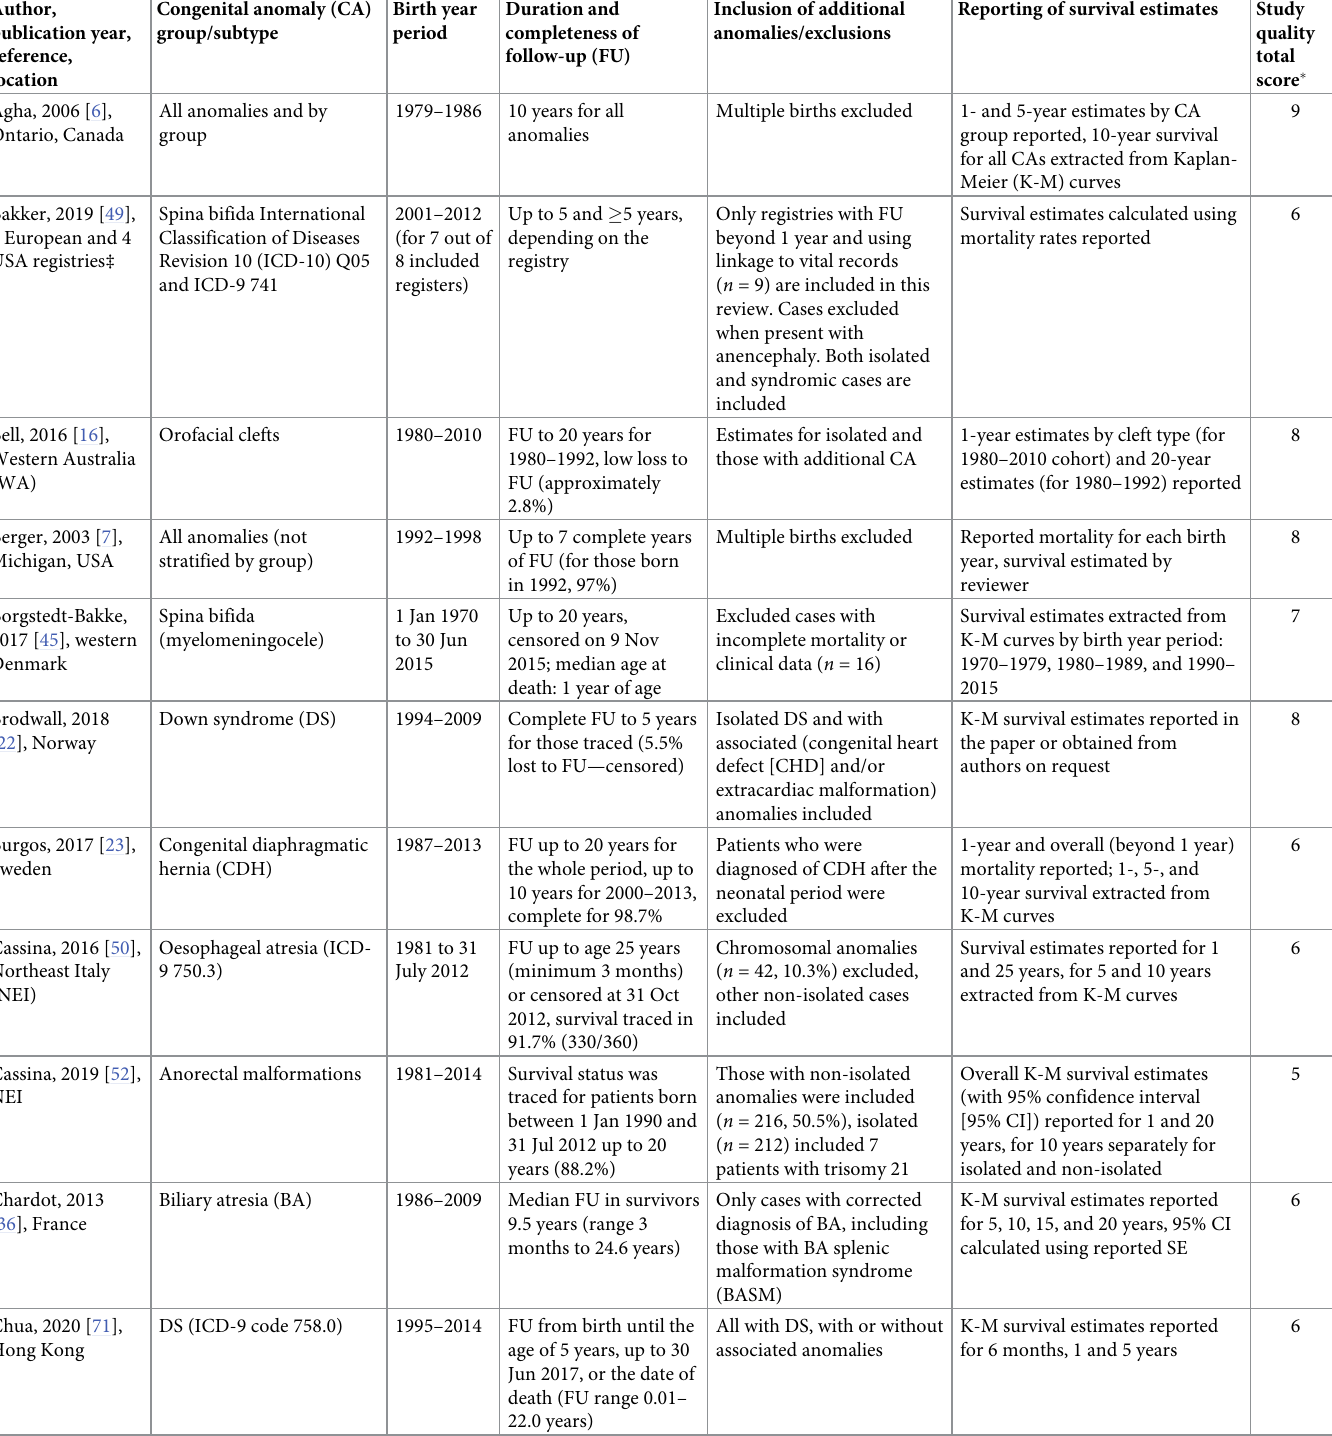
Table 1. Description of included